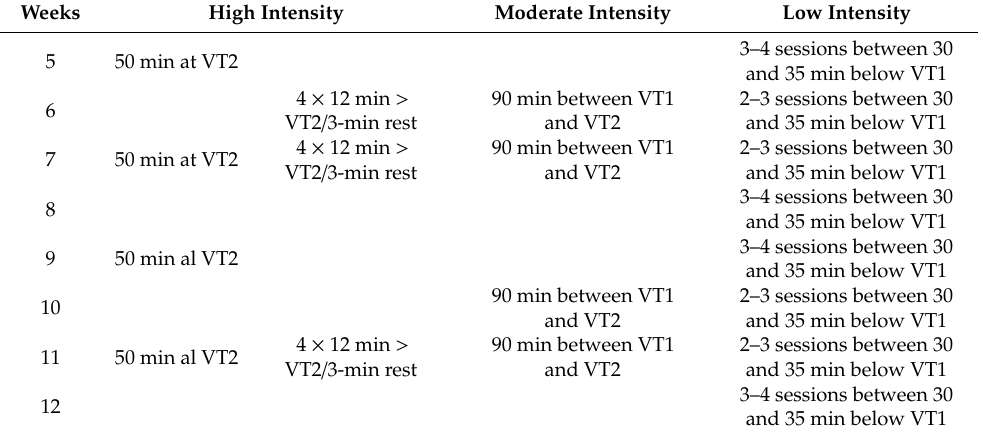
Table 2. Periodization and training distribution for TRAD-G during training period